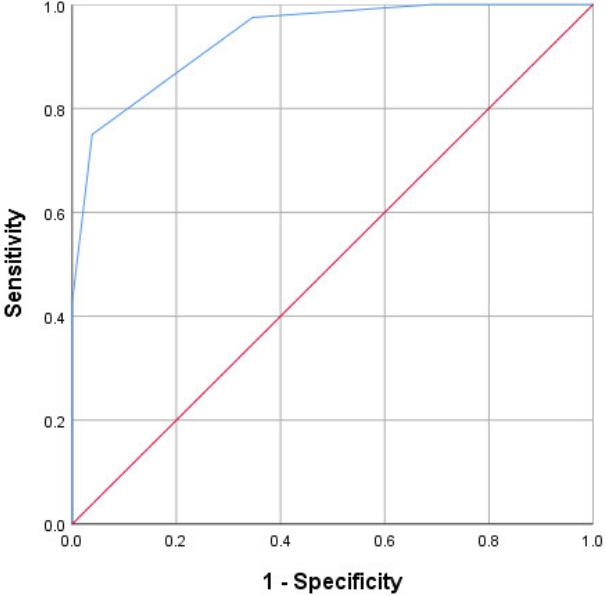
Figure 1. Receiver operating characteristic (ROC) curve of the scale obtained when predicting the group allocation (cluster headache vs controls). The scale comprises items 6, 9, 11, 15 and 22 as diagnostic questions; its area under the curve was 0.938.